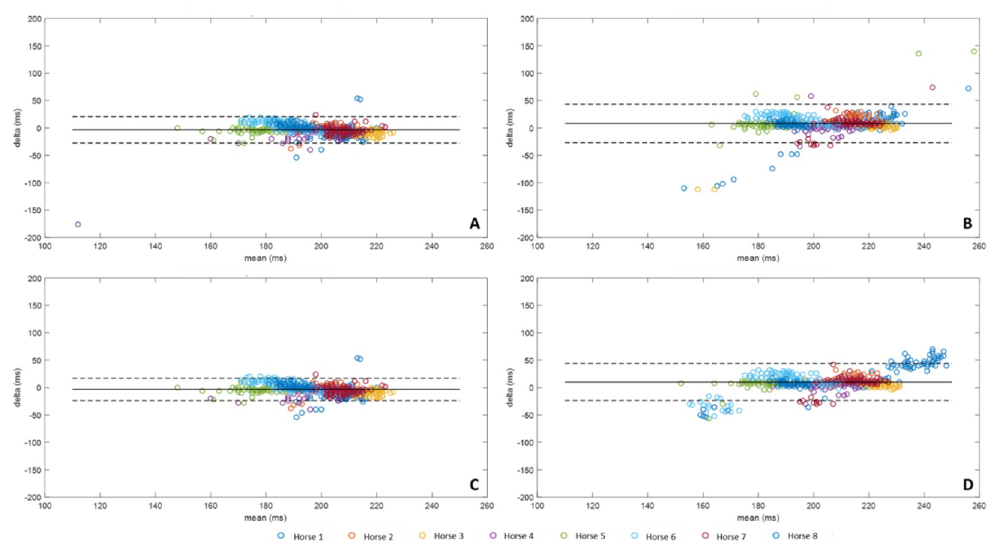
Figure 8. Bland‐Altman comparison of the Stance Duration , calculated from the Foot on and Foot off obtained from the four methods developed with IMU data and MoCap. Accuracy (bias between each method and MoCap) and limits of agreement (95% limits of agreement) of method A were represented on the upper left corner ( A ), method B on the upper right corner ( B ), method C on the lower left corner ( C ), and method D on the lower right corner ( D ).